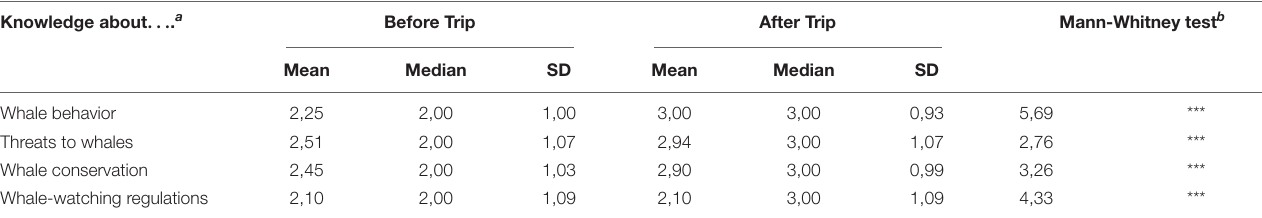
TABLE 2 | Differences in knowledge about whales before and after the whale-watching